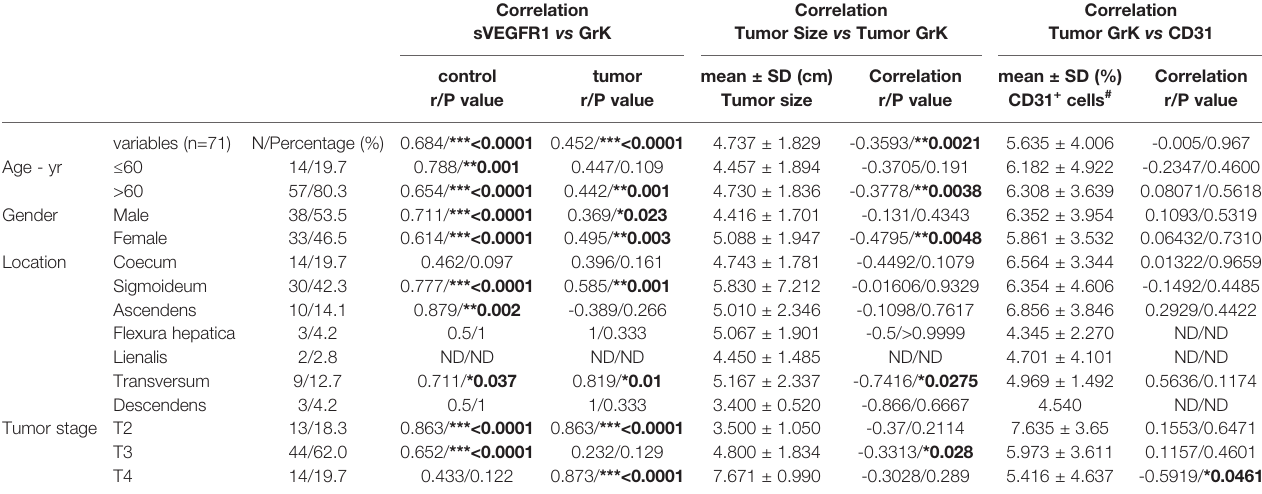
TABLE 2 | Correlation between sVEGFR1, Tumor size, CD31 and